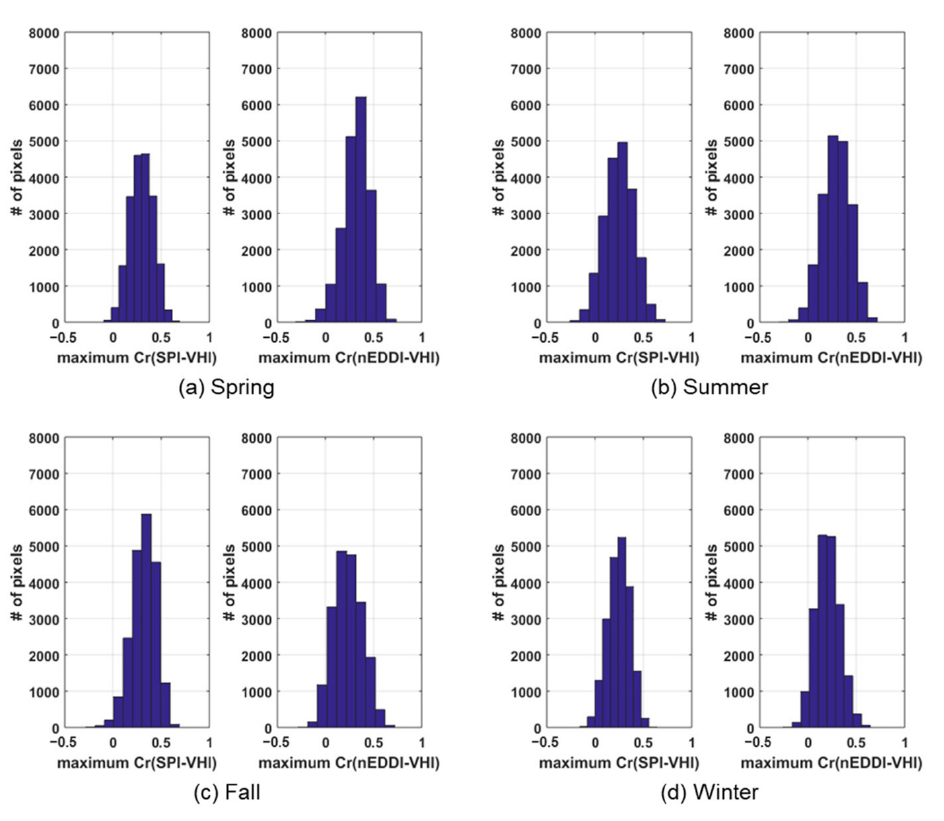
Figure 6. Cross-correlation between SPI (or nEDDI) and VHI. The horizontal axis is the interval of the cross-correlation coefficient, and the vertical axis is the number of pixels belonging to each cross-correlation coefficient